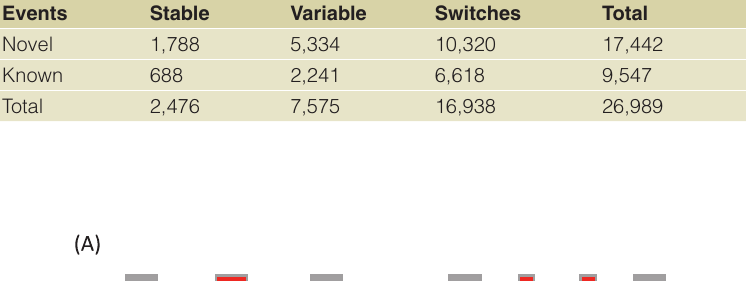
Table S13. Variability of novel exon skipping events compared to known events. Novel events are depleted in ‘switches’ compared to known events (test of